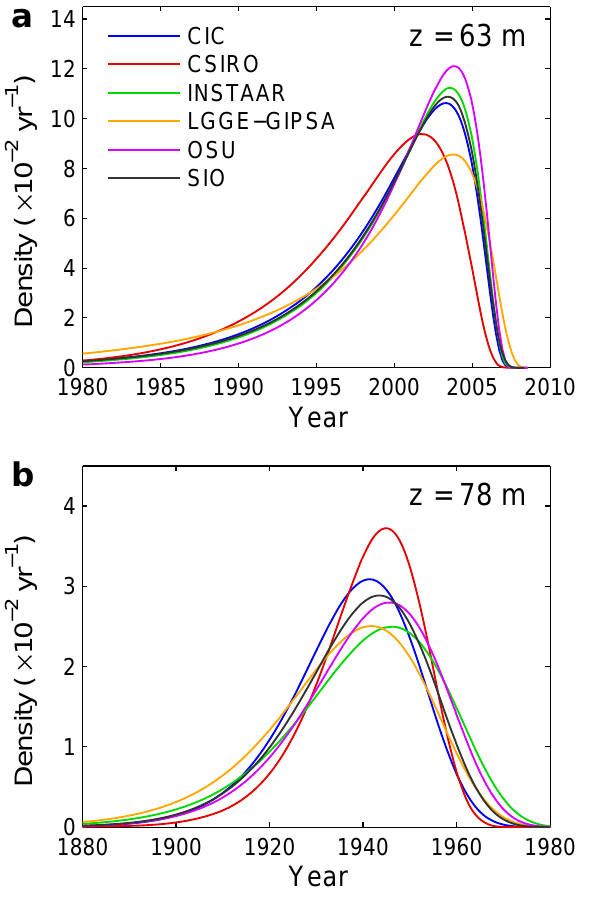
Fig. 8. Comparison between the EU and US boreholes. (a) Semi- log plot of the total CO 2 diffusivity profile D total (z) = D CO D eddy ( z ) averaged over all six firn models. (b) Age distributions at depths z = 63 m (lock-in depth) and z = 76 m (bottom of LIZ) averaged over five firn models. The CSIRO model is excluded in the age distribution comparison as the US age distribution at z = 76 m is unreliable